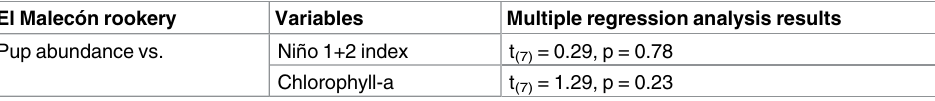
Table 5. Multiple regression analysis results. Relationships betweenpup abundance in the El Maleco´n rookery and environmental variablesfrom 2005 to 2015; significantvalues are shown in bold. El Maleco´n rookery